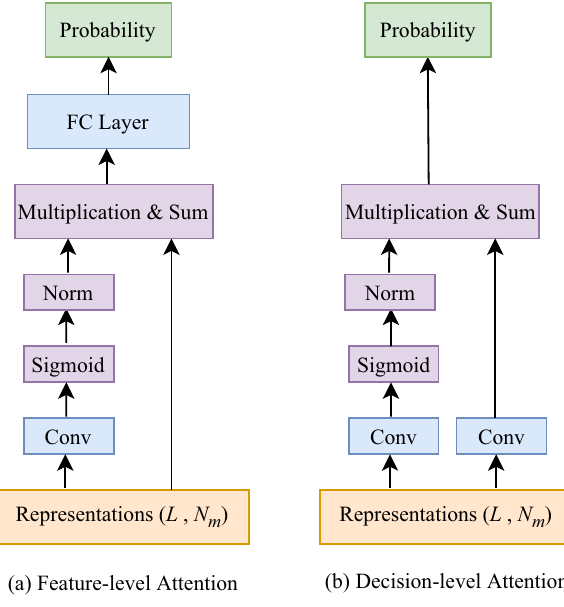
Figure 1. The attention-based ensemble